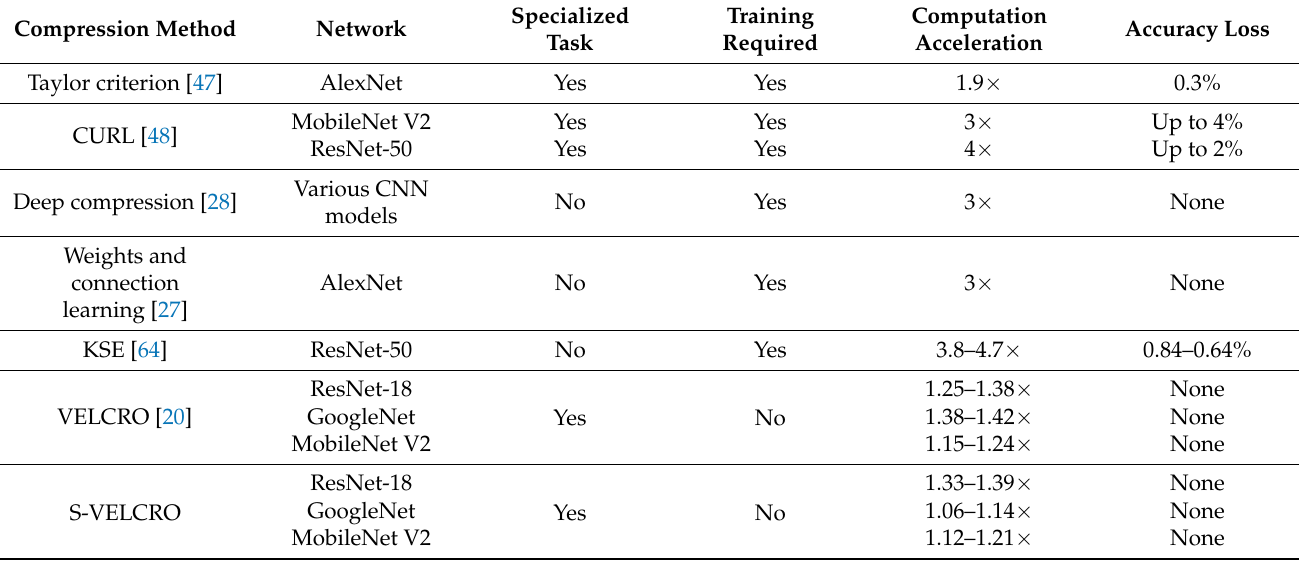
Table 3. Comparison of S-VELCRO with prior compression techniques.